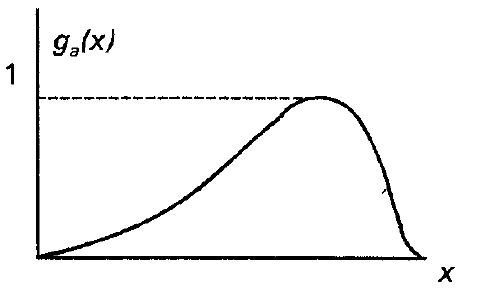
Figure 3: Utility of feature a, as a function g.(x) of SCA level x.